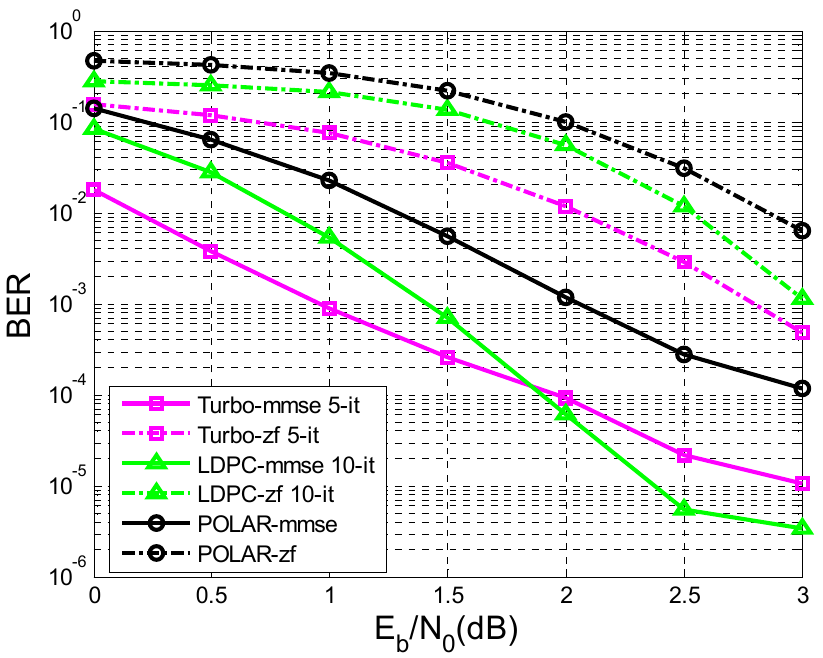
Figure 11. BER vs. SNR for different codes in the case of MMSE and ZF equalization in the case of perfect channel estimation (K = 342 bits and h = (0.18 0.85 0.32)).